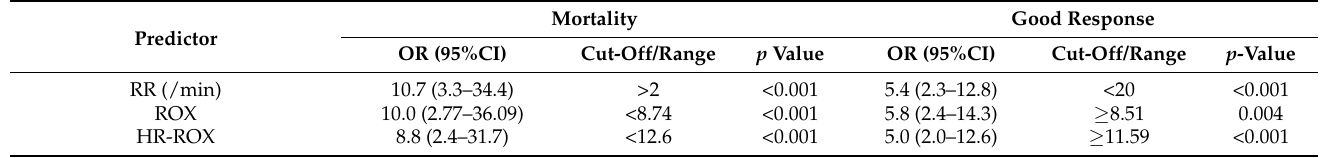
Table 5. Mortality predictors (assessed on the day of tocilizumab initiation, apart from two last pre- dictors, which were measured during admission) and their comparison to prediction of good clinical response. Cut-offs are listed as linear predictors and range is presented for nonlinear associations. Analyses have been conducted on adjusted